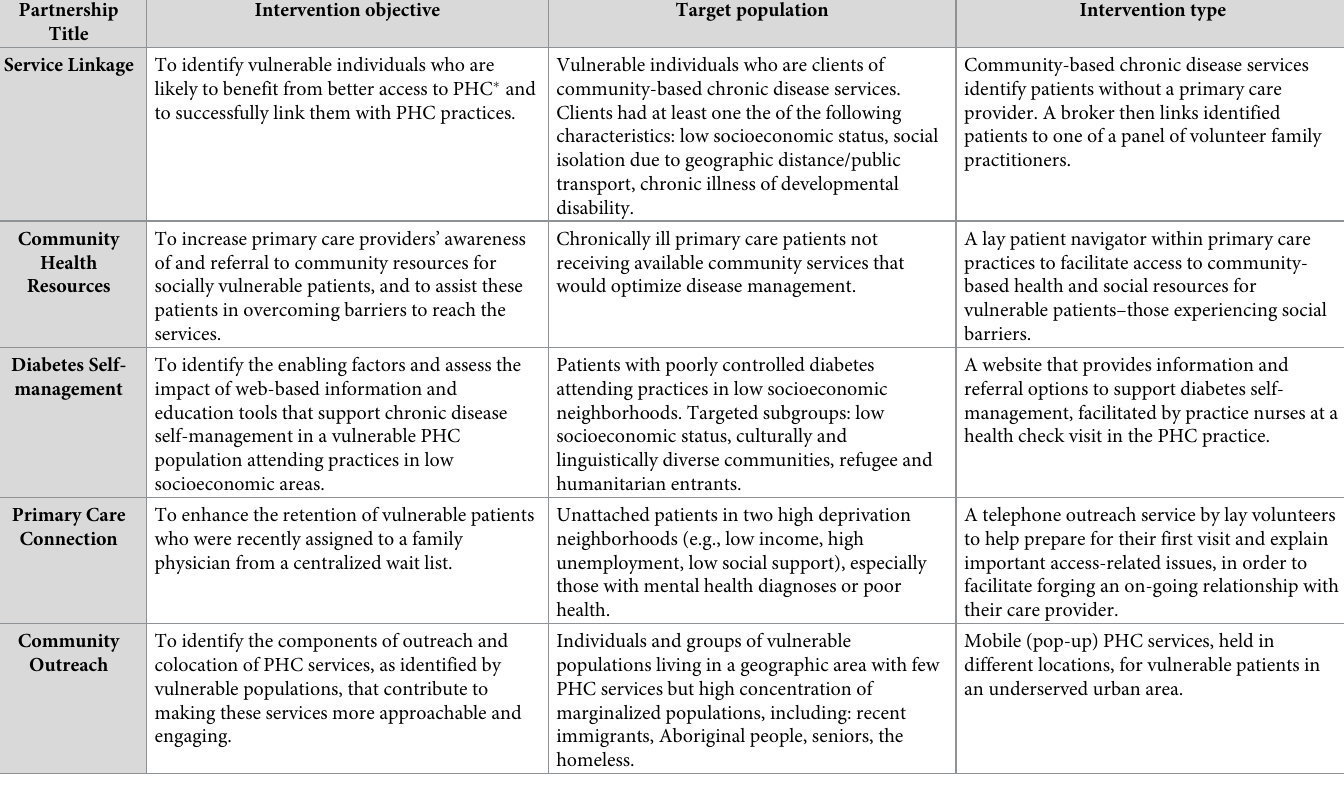
Table 1. Overview of interventions in five partnerships [adapted from 26,27]. Intervention objective Target population Intervention